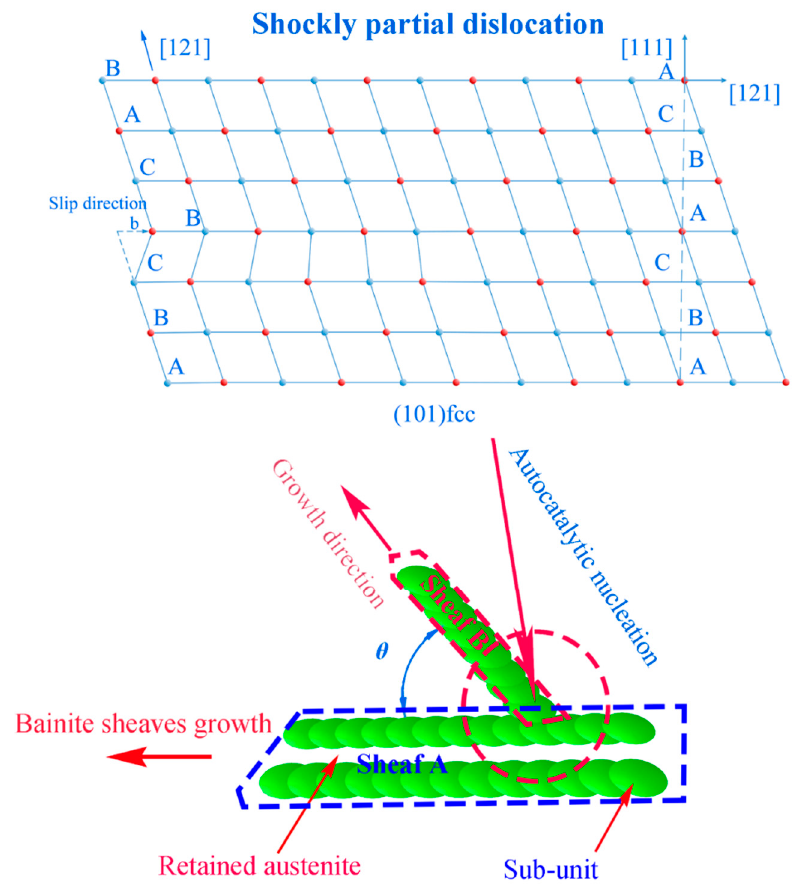
Figure 10. Schematic illustration describing the growth intersection angle of the initial bainitic lath and the lath caused by autocatalysis.